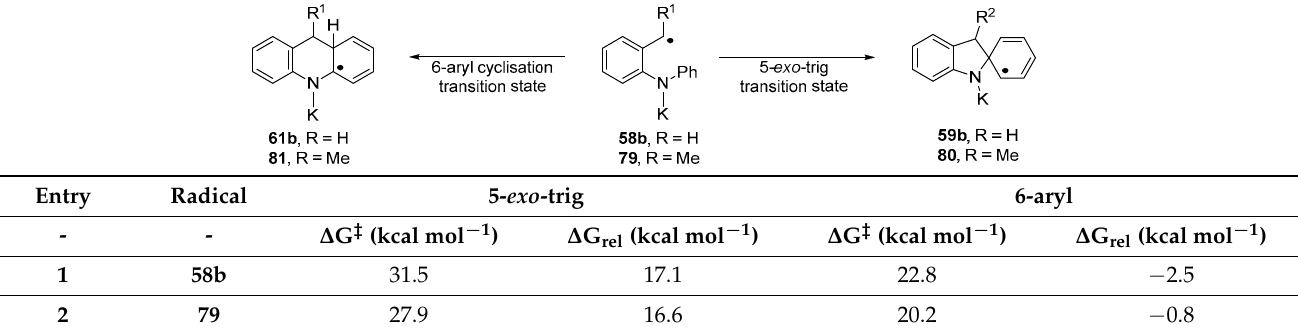
Table 3. Summary of activation energies and relative change in Gibbs free energy for the cyclisation steps for radical 79 compared to 58b .